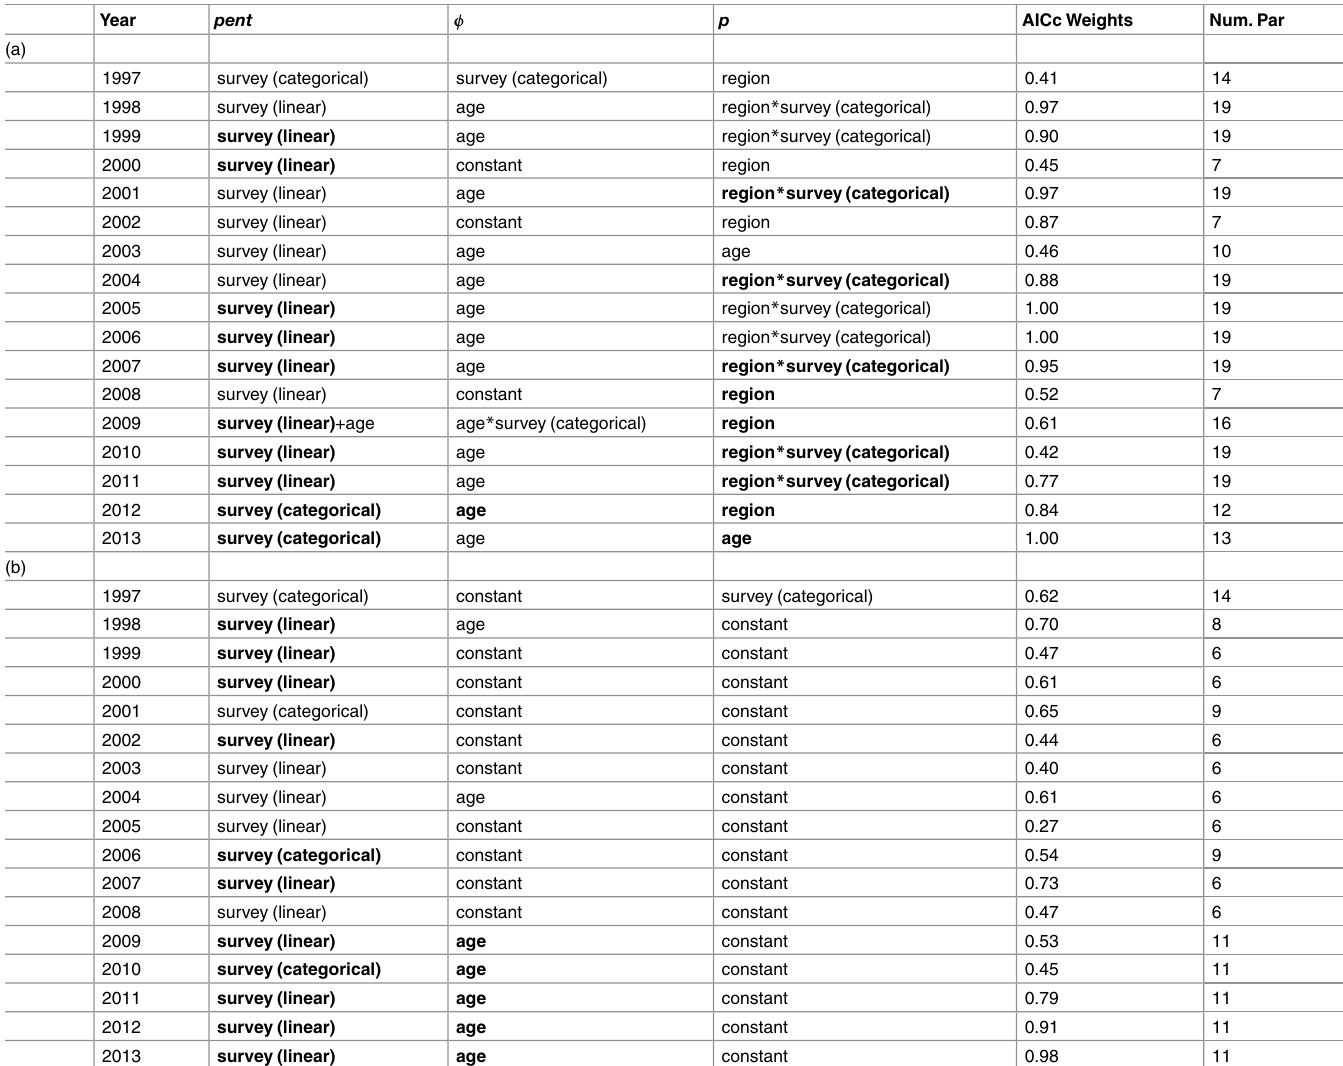
Table 1. Summaryof best supportedORDMSmodelsused to estimate snailkite populationsizeand age structurefrom 1997–2013, thatincorpo- rate regionalvariation(a) versus modelsfor the entirebreeding range(b). Bold indicatessignificanteffect based on non-overlapping 95%CI.See Sup- portingInformation for associated point estimatesand 95%CI of those parameters (S2 Fig and S3 Fig),and moredetailson all modelsconsidered (S2 Table and S3